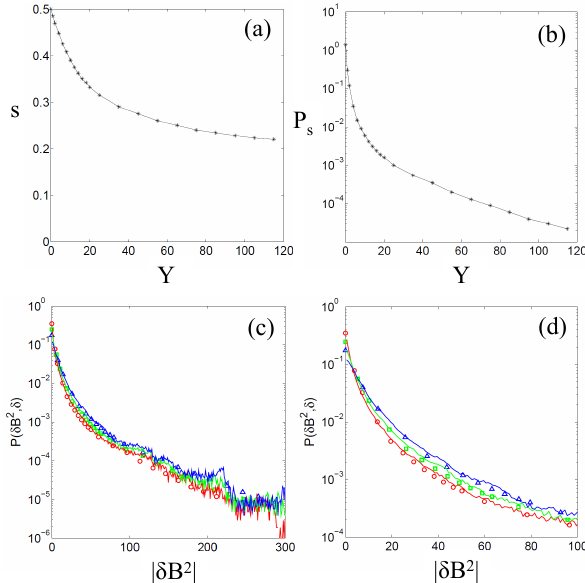
Fig. 11. Fluctuations of B 2 based on a 2-D MHD simulation. (a) and (b) : ROMA spectrum s(Y ) and scaled PDF P s (Y) . (c) and (d) : plots of P( | δB 2 | , δ) : computed PDFs from the ROMA re- lations with s(Y ) and P s (Y) given in (a) and (b) are shown by markers; PDFs from the MHD simulation are given in solid curves. Red circles: δ = 32 1 ; green squares: δ = 48 1 ; and blue triangles: δ = 96 1 . (d) is an enlarged view for | δB 2 | ≤ 100. 1 =grid spac- ing=2 π /1024; | δB 2 | is in the units of bin size, which is set to be | δB 2 | max /800. The PDFs from the simulation are from Chang and Wu (2008).